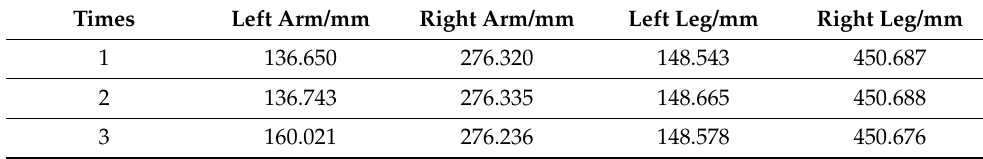
Table 2. Geometric parameters of robot pose determination and tracking.